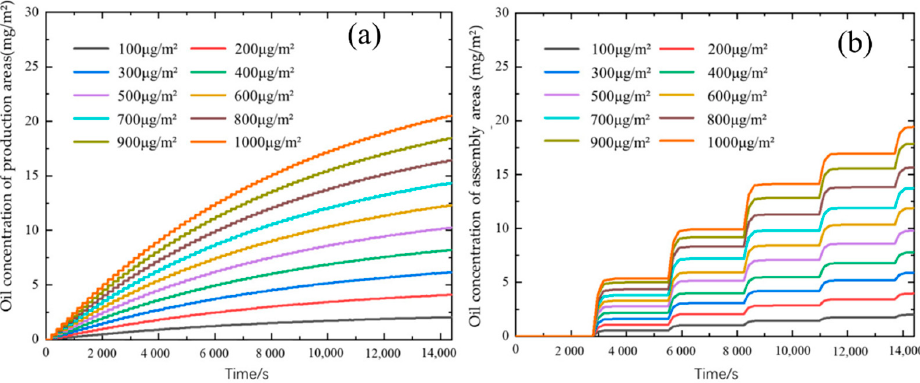
Figure 7. Influence of initial oil contamination concentration on the change in oil contamination concentration. ( a ) workbenches in the production area; ( b ) assembly tables in the assembly area.